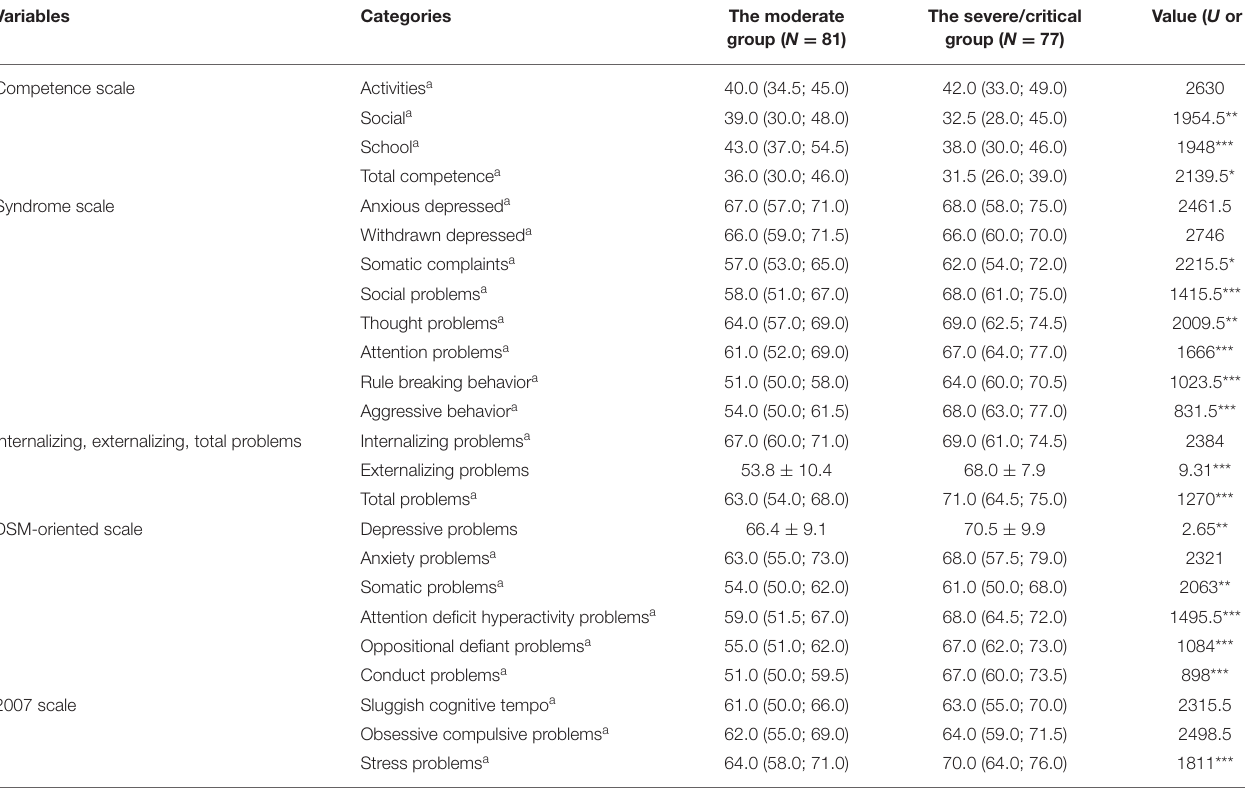
TABLE 5 | Differences in CBCL scores between two Latent Classes ( N =